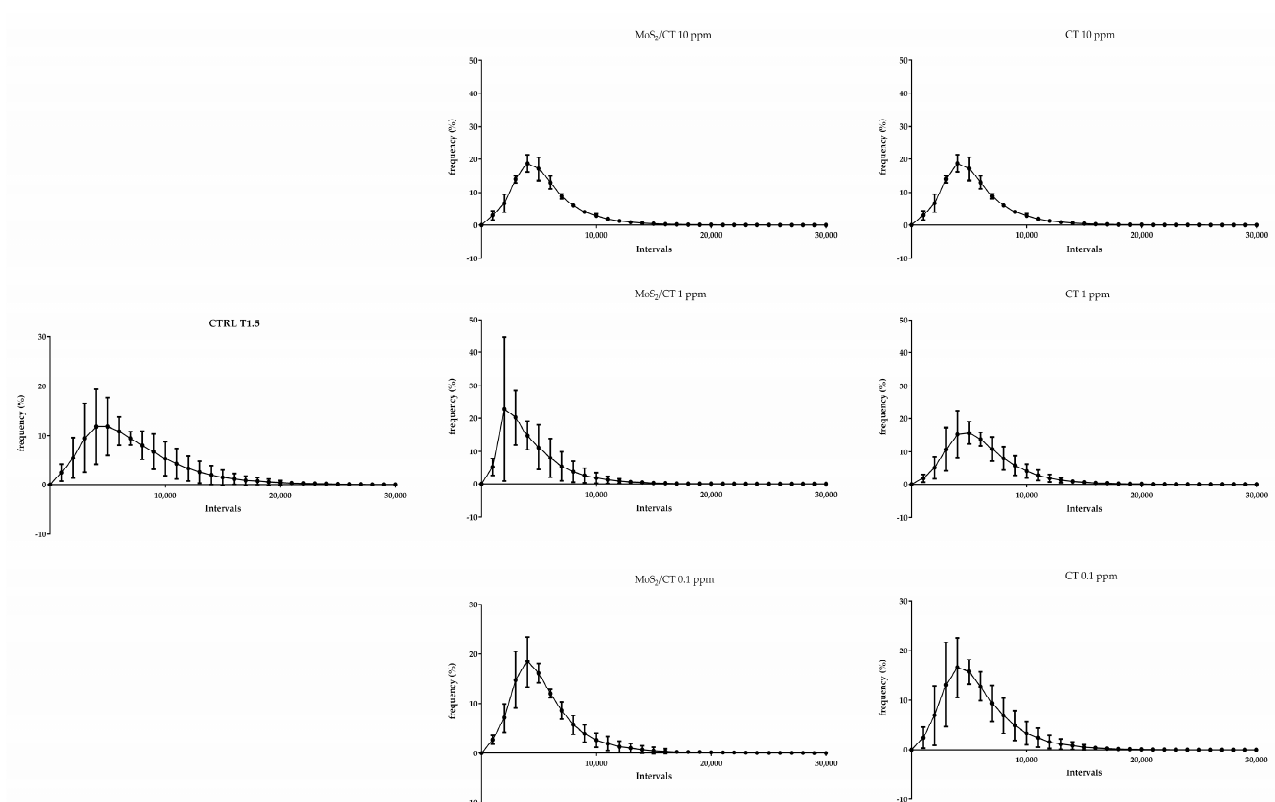
Figure 5. Flow cytometry analysis of mitochondrial activity. The graphs show the frequency of spermatozoa emitting a specific fluorescence intensity, which was subdivided into intervals ranging from 0 to 30,000 a.u. Capacitation was performed up to 1.5 h. Mitotracker Red was used in combination with a near-IR probe. Three independent technical and biological experiments were performed ( n = 3).